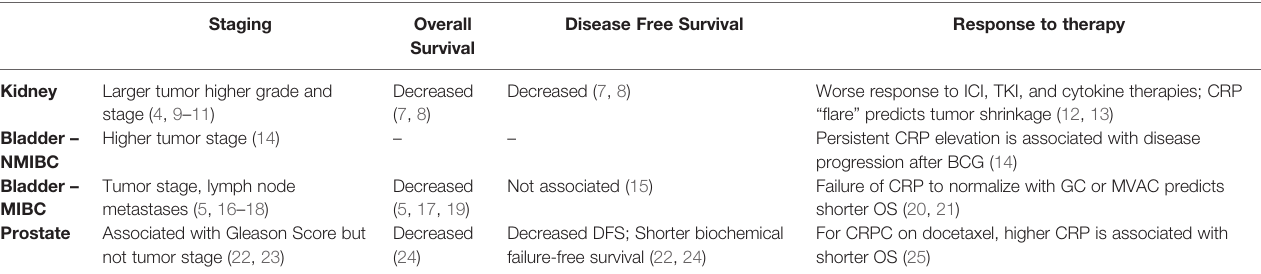
TABLE 1 | The association of elevated CRP levels with clinical response for kidney, bladder, and prostate cancer.